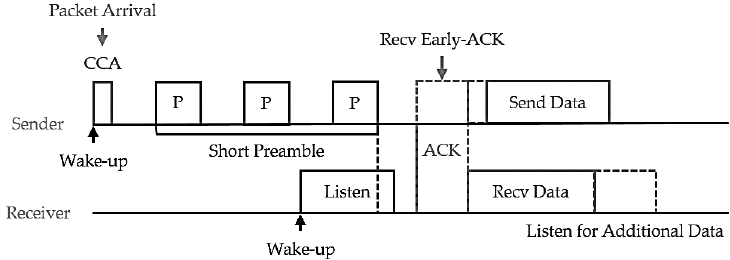
Figure 3. X-MAC protocol.